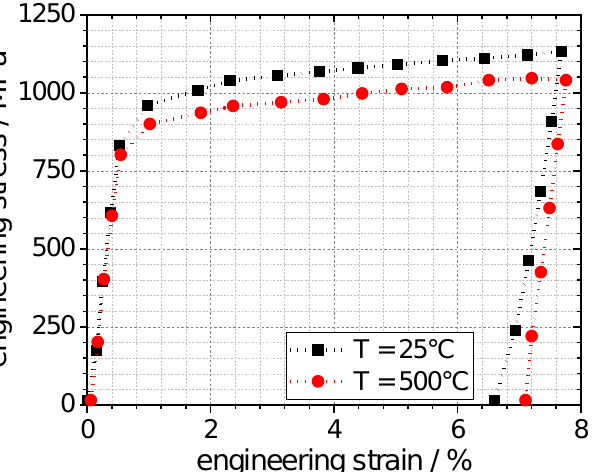
Figure 3. Macroscopic engineering stress/strain curves of the Ni-based VDM Alloy 780 at 25 and 500 ◦ C. The symbols indicate the points of constant strain holding while the diffraction patterns were taken.